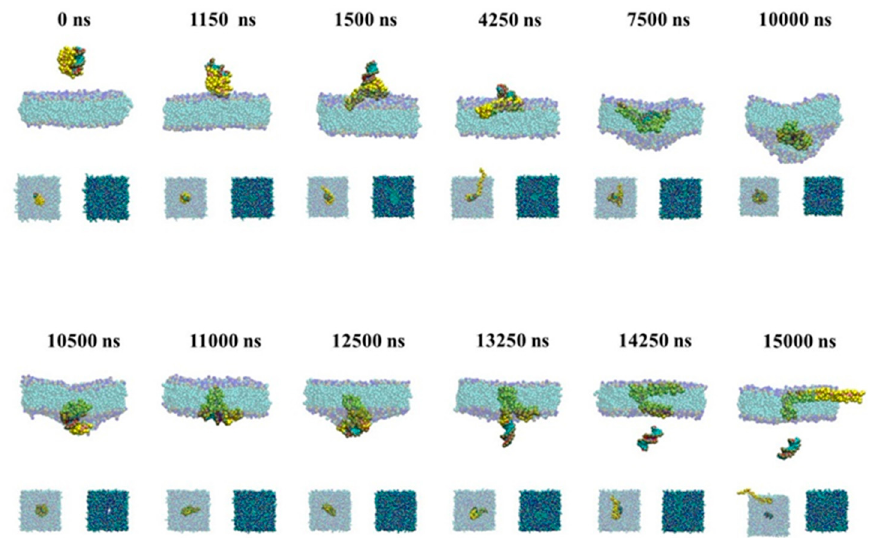
Figure 5. Snapshots of the passive transport of siRNA assisted by PMAL. The major graphs are front view of process and the small graphs are upper